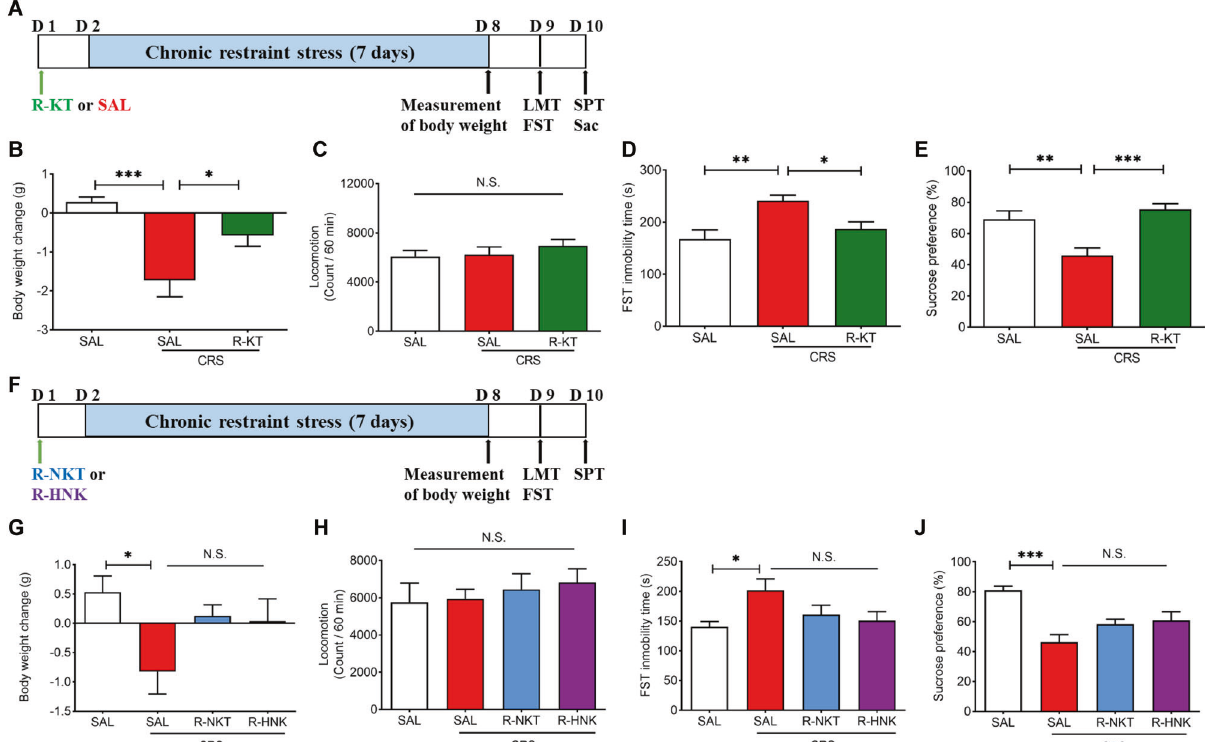
Fig. 1 Prophylactic effects of ( R )-ketamine, not its metabolites, on CRS model of depression. A Treatment schedule. ( R )-ketamine (10 mg/ kg) or saline (10 ml/kg) was i.p. injected to adult mice 1 day before chronic restraint stress (CRS) (day 1). Subsequently, mice were subjected to CRS for 7 days (day 2 – day 8). Locomotion test (LMT), forced swimming test (FST) and sucrose preference test (SPT) were performed on day 9 and day 10, respectively. The prefrontal cortex (PFC) was collected after the SPT (day 10). B Body weight change (one way ANOVA: F 2,27 = 11.02, P = 0.0003). C Locomotion test (one way ANOVA: F 2,27 = 0.648, P = 0.531). D FST (one way ANOVA: F 2,27 = 7.793, P = 0.002). E SPT (one way ANOVA: